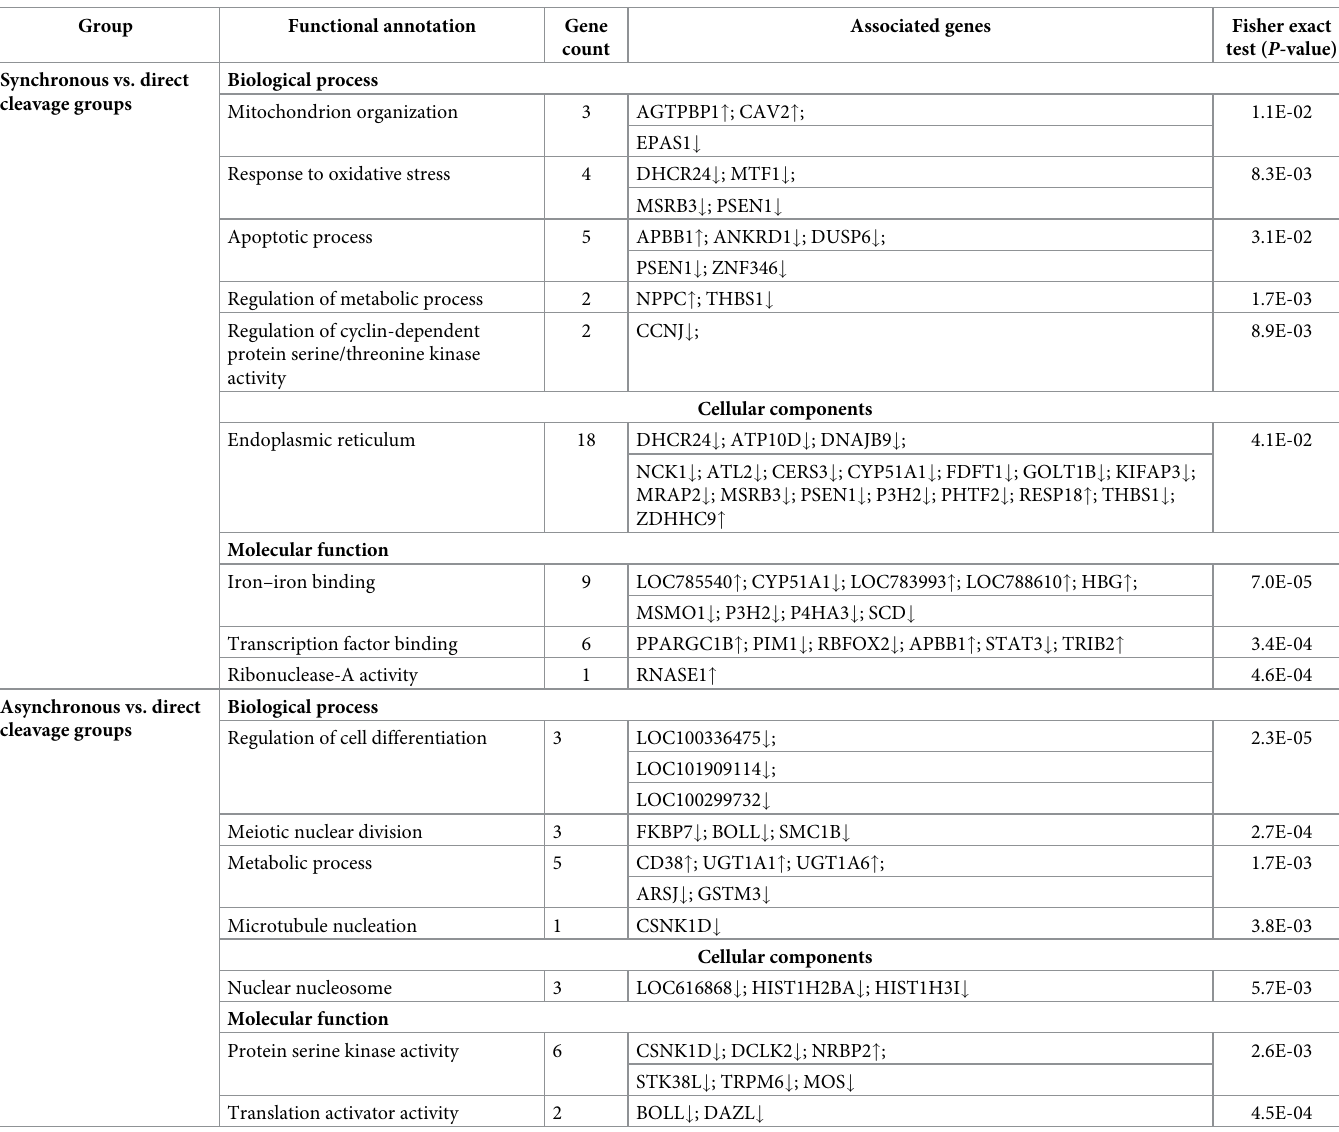
Table 5. Enrichment analysis of non-overlapping genes in blastocysts that developed from synchronously or asynchronously cleaved embryos that are differentially expressed in directly cleaved embryos (David).